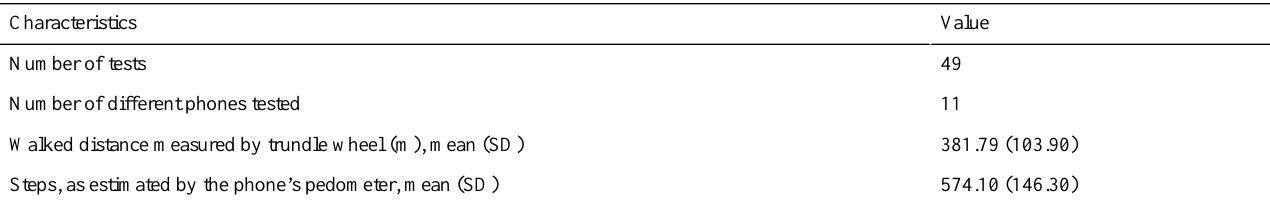
Table 1. Summary characteristics of the indoor tests.